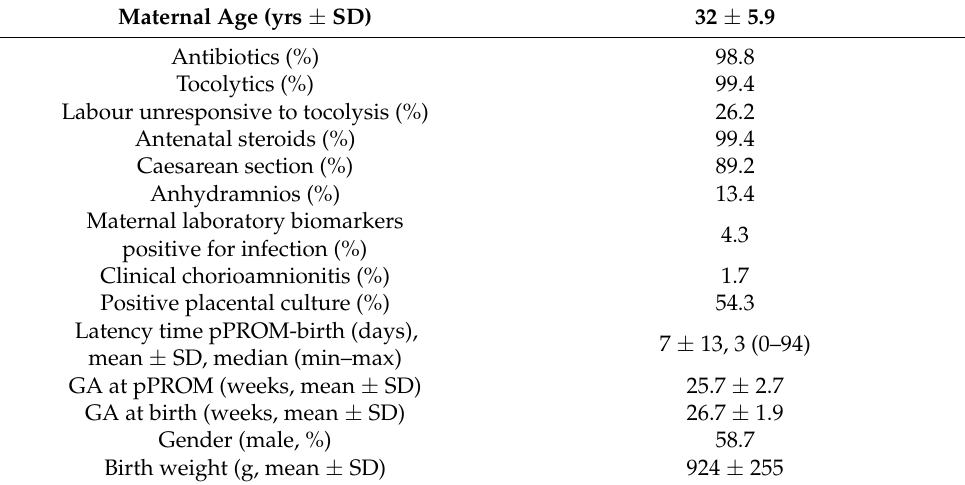
Table 1. Maternal and patient characteristics of the whole study population ( n = 363).